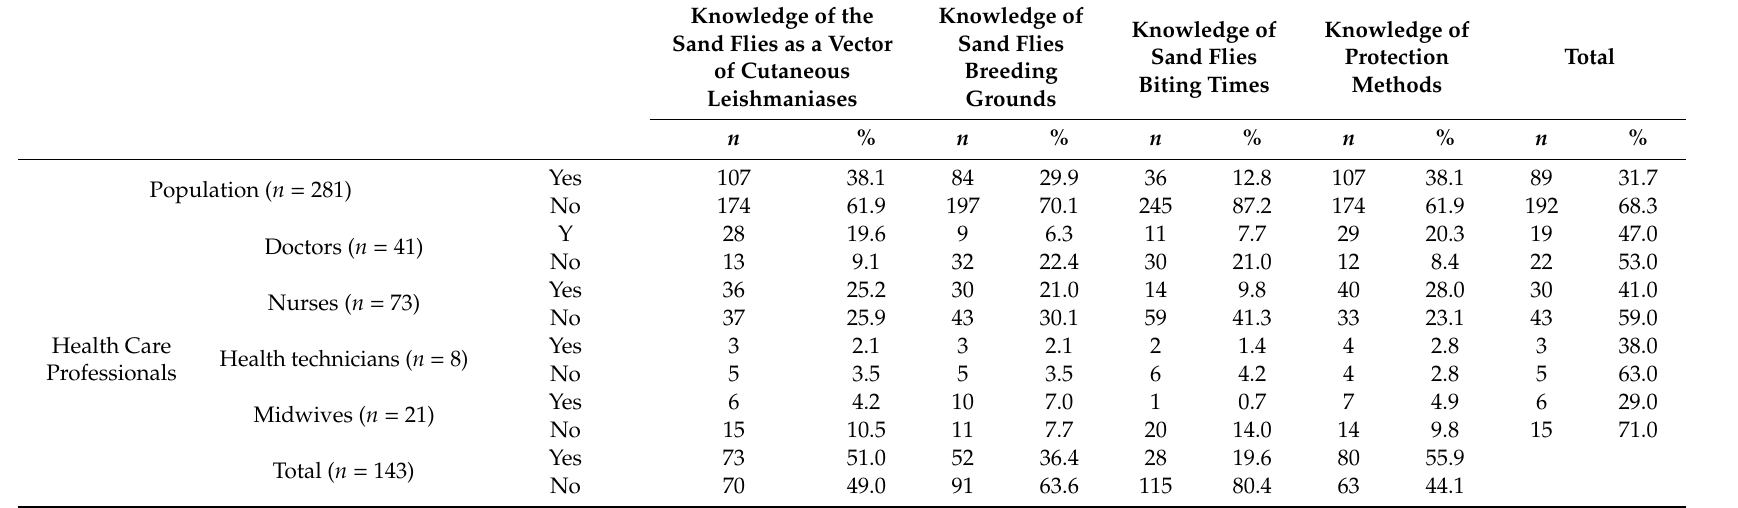
Table 2. Knowledge on the biology and ecology of sand flies and means of control.